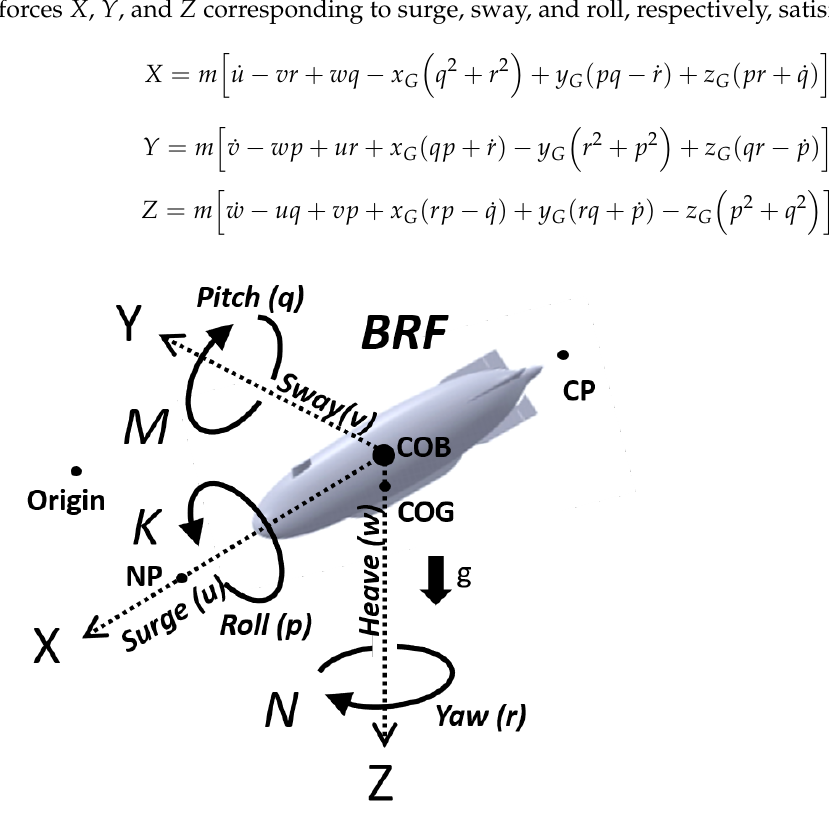
Figure 1. Reference for body frame and world frame coordinate system used in this